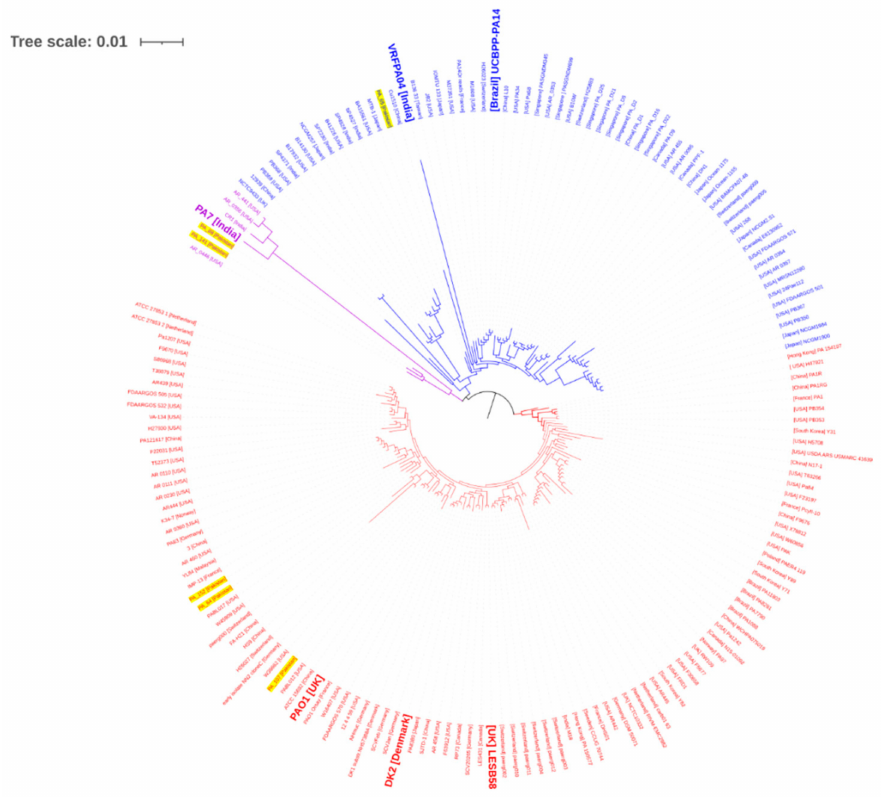
Figure 3. Phylogenetic analysis of the P. aeruginosa isolates. Roary identified and clustered core genes of 180 isolates (174 global representative and six study genomes). PRANK aligned the core genes. FastTree used SNPs in the alignment to produce the relationship of isolates via newick format. Scale bar represents the number of substitutions per site. Relative position of the study strains is highlighted in yellow. Different branch colors indicates different groups, while reference strains are indicated in bold